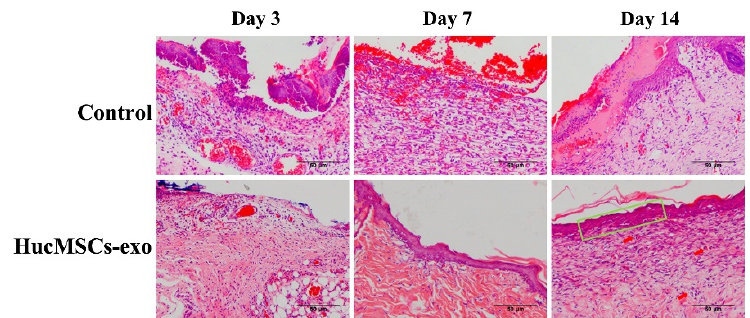
Figure 4. H&E staining of diabetic wound tissues treated with PBS (control) and hucMSCs-exo on days 3, 7, and 14. Red arrow: blood vessels, green rectangle: characteristic epithelium.